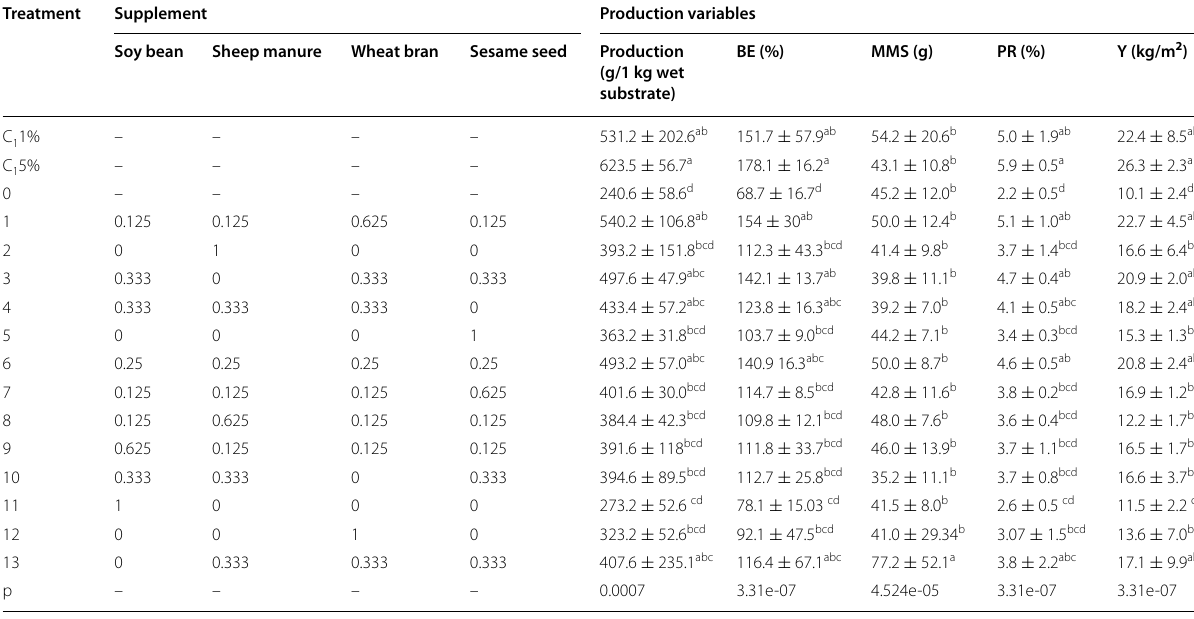
Same letters in the same column indicate no statistical difference between treatments (alpha